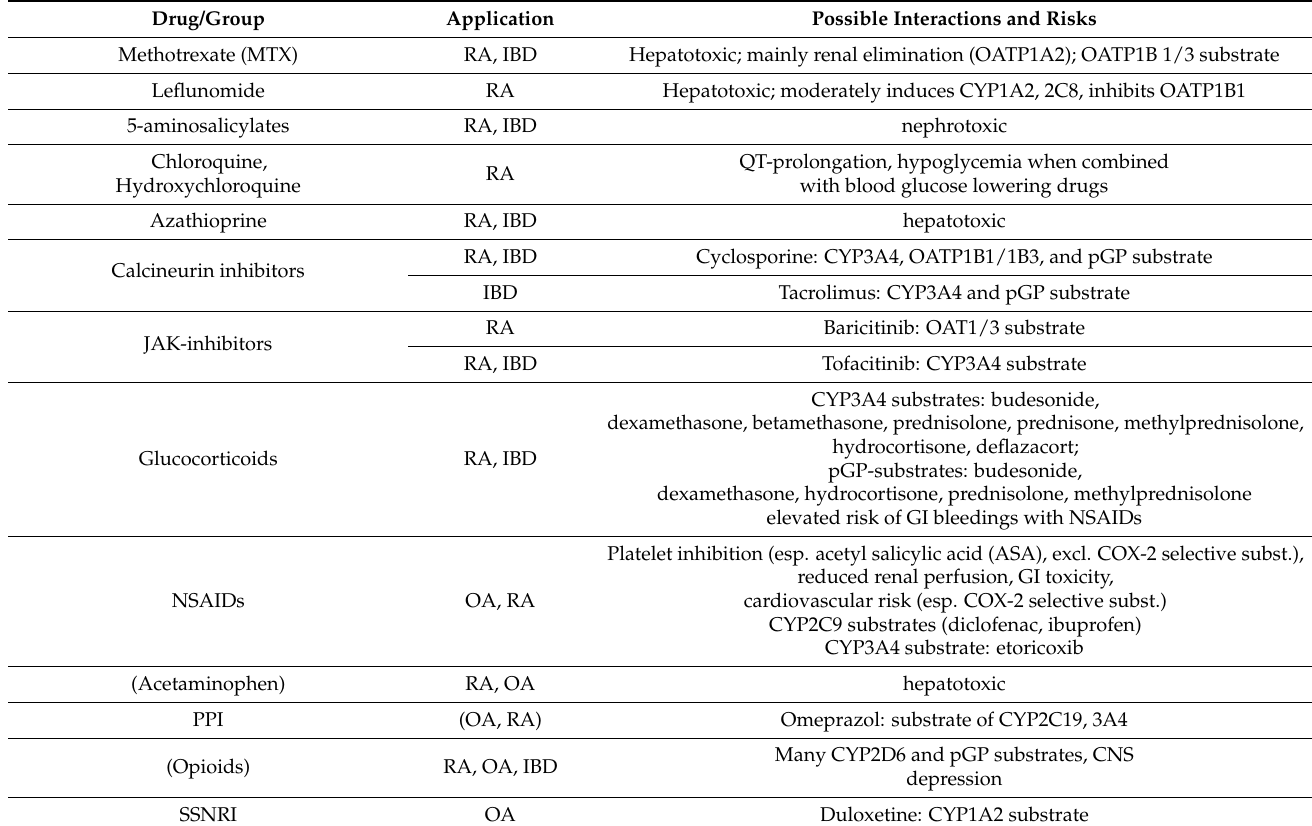
Table 2. Conventional drugs in therapy of RA, IBD, or osteoarthritis and their interaction potential (focus on mechanisms that can influence the effect of the drug or elevate its risks, not on their potential to influence